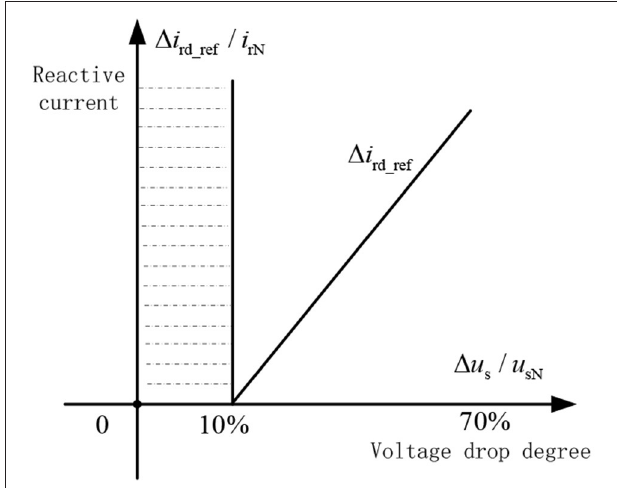
FIGURE 4 | Relationship between the deviation of u s and rotor reactive